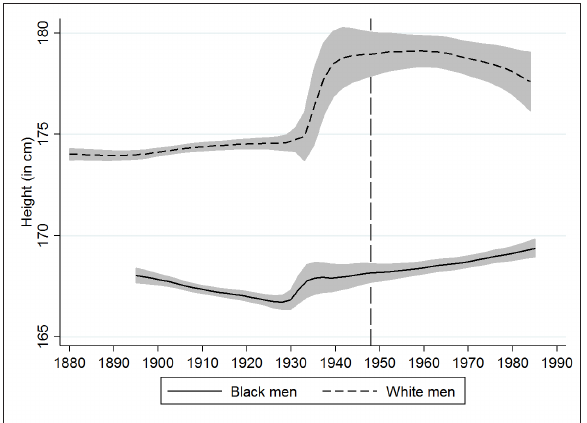
Figure 6: Height of black and white men over the 20th century.